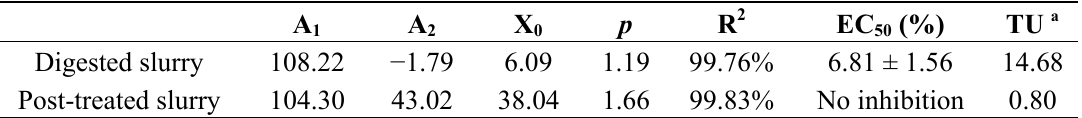
Table 2. Nonlinear dose-response models with some statistics, EC wastewater to luminescent